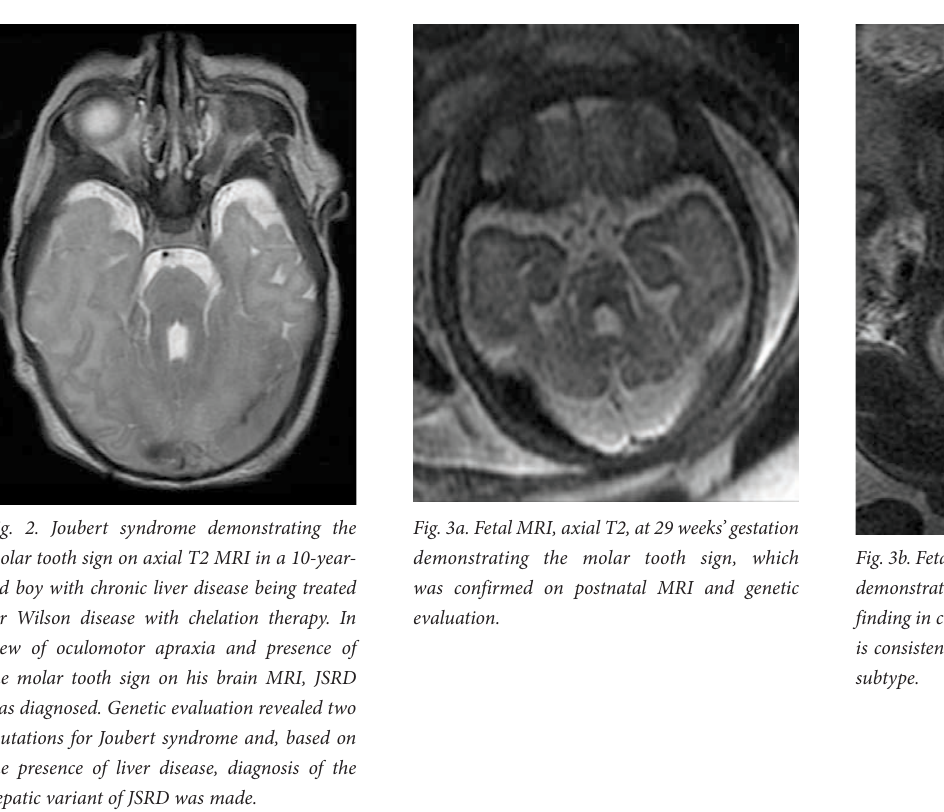
Fig. 1a. Axial T2 MRI at the level of the midbrain demonstrating the molar tooth sign (i.e. thickened superior cerebellar peduncles (arrow indicates left-side peduncle) with a deep interpeduncular fossa) in an 8-year-old patient diagnosed with Joubert syndrome in combination with clinical and imaging findings. This appearance is characteristic of non-decussation of the superior cerebellar peduncles. There is marked vermian hypoplasia.